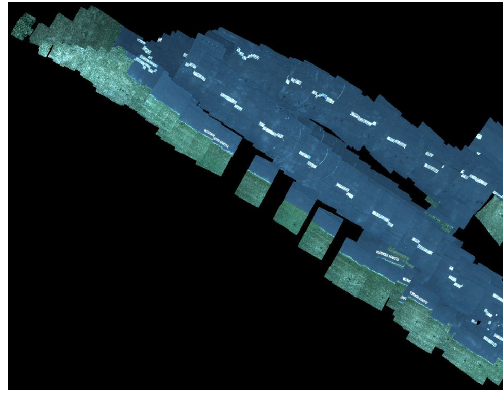
Figure 14. Discontinuity in assembled aerial imagery due to switching from single point position (SPP) fix to RTK fix. Note that the runway only has a single center white dashed line.